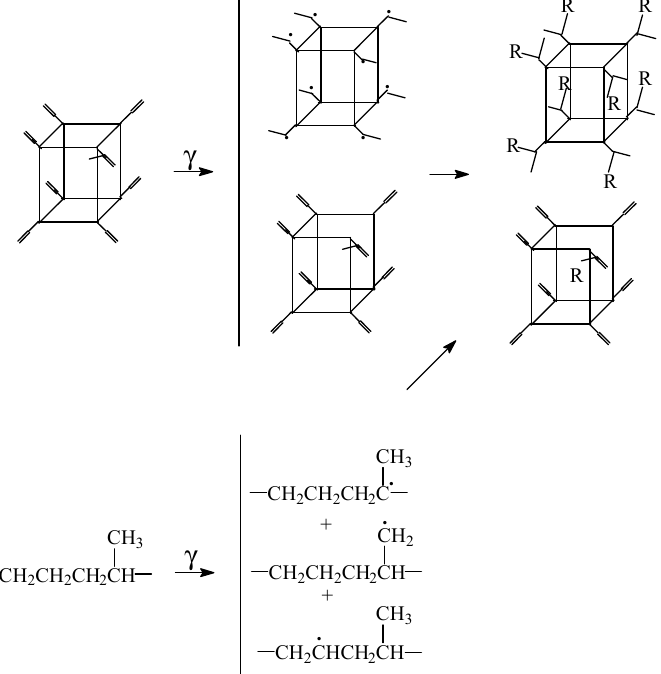
Figure 1. Proposed scheme for the stabilization mechanism of POSS in the γ -irradiated EPDM.